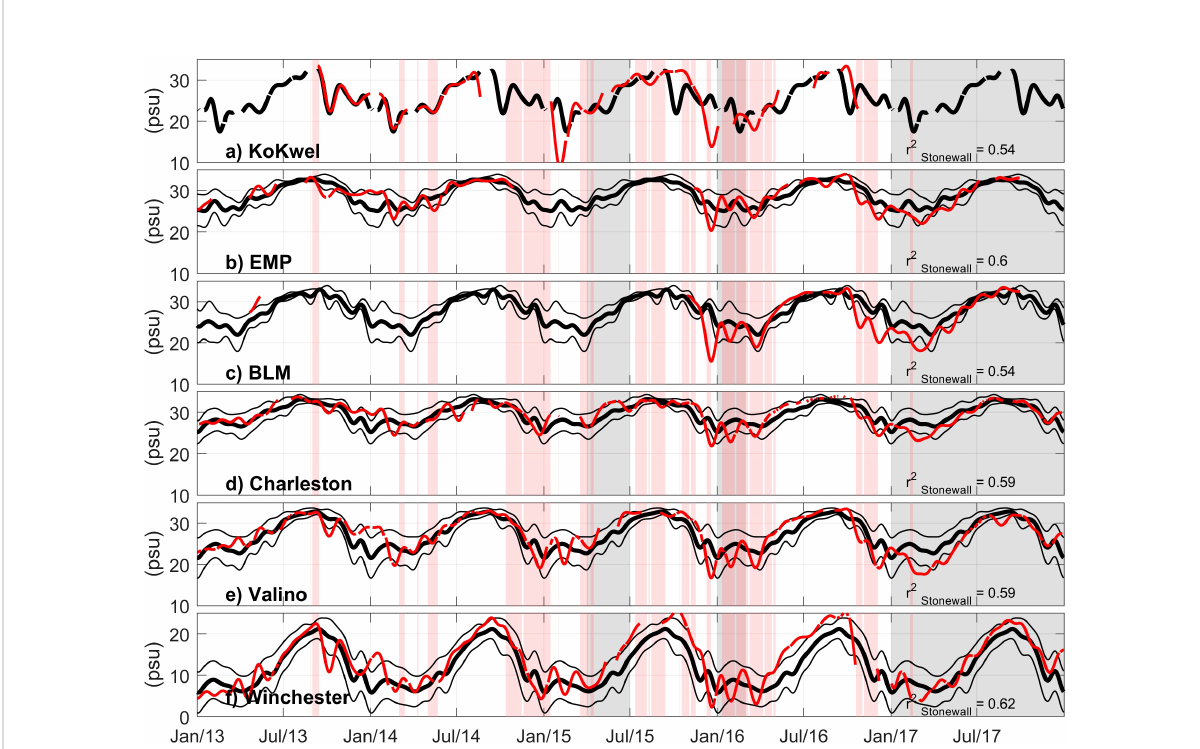
FIGURE 7 Coos Estuary salinity during 2013-2017, thick black lines show 2004-2014 climatological mean, thin black lines show ±1 standard deviation, thin red line shows daily averages with a 30-day low pass fi lter. Red bands show periods in which water temperature at Charleston WQ is 1 standard deviation above the 2004-2014 climatology (black line in Figure 6D). Gray bands show periods in which eelgrass density at Valino is below the 2004-2014 climatology by one standard deviation. Correlation between Charleston WQ and the Stonewall buoy shown in text. (A) KoKwel Wharf, (B) EMP, (C) BLM, (D) Charleston, (E) Valino and (F) Winchester